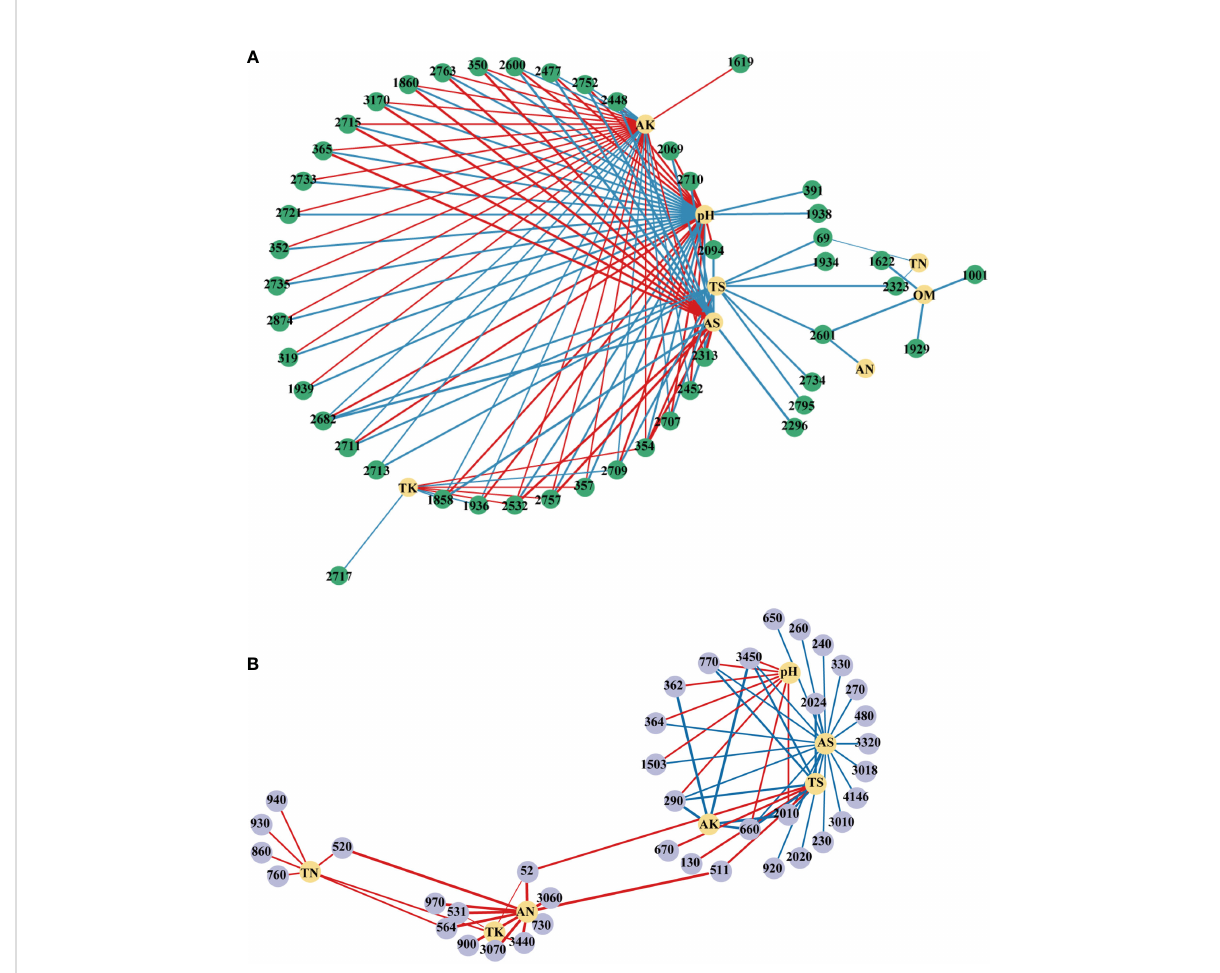
FIGURE 9 Network analysis revealing associations between soil physicochemical properties and top100 OTUs (A) and pathways (B) . A blue line indicates a negative interaction, while a red line indicates a positive interaction. The numbers in the fi gure represent the numbers of the OTU or pathway. LK, Low amount of K 2 SO 4 ; MK, Middle amount of K 2 SO 4 ; HK, High amount of K 2 SO 4 . OM, organic matter; TN, total nitrogen; TK, total potassium; TS, total sulfur; AN, available nitrogen; AK, available potassium; AS, available